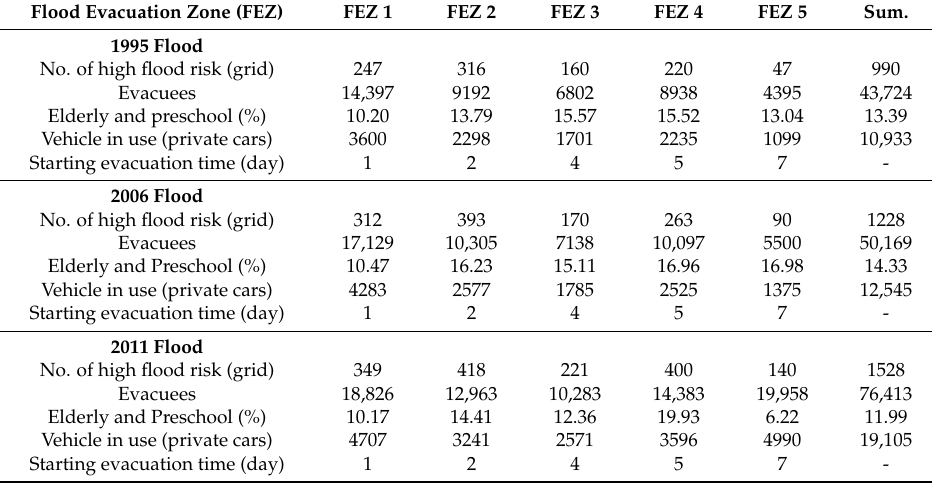
Table 5. The detail of each flood evacuation zone in the middle reach of